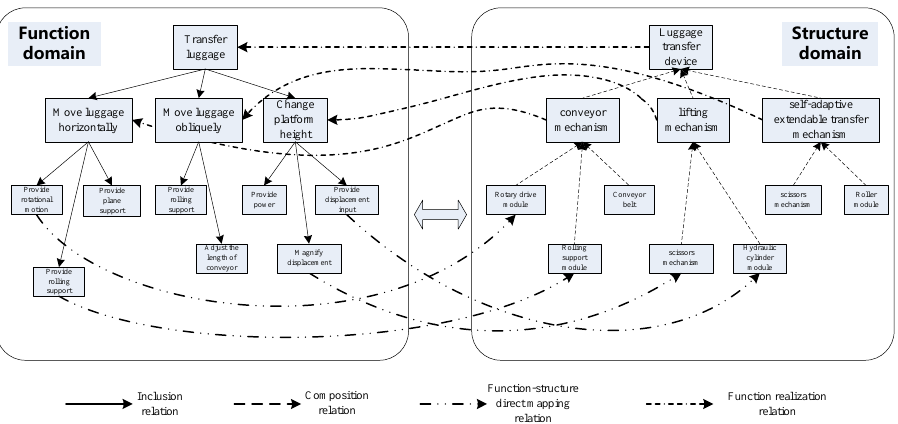
Figure 8. The three-layer function-structure mapping model of the self-adaptive luggage transfer device.